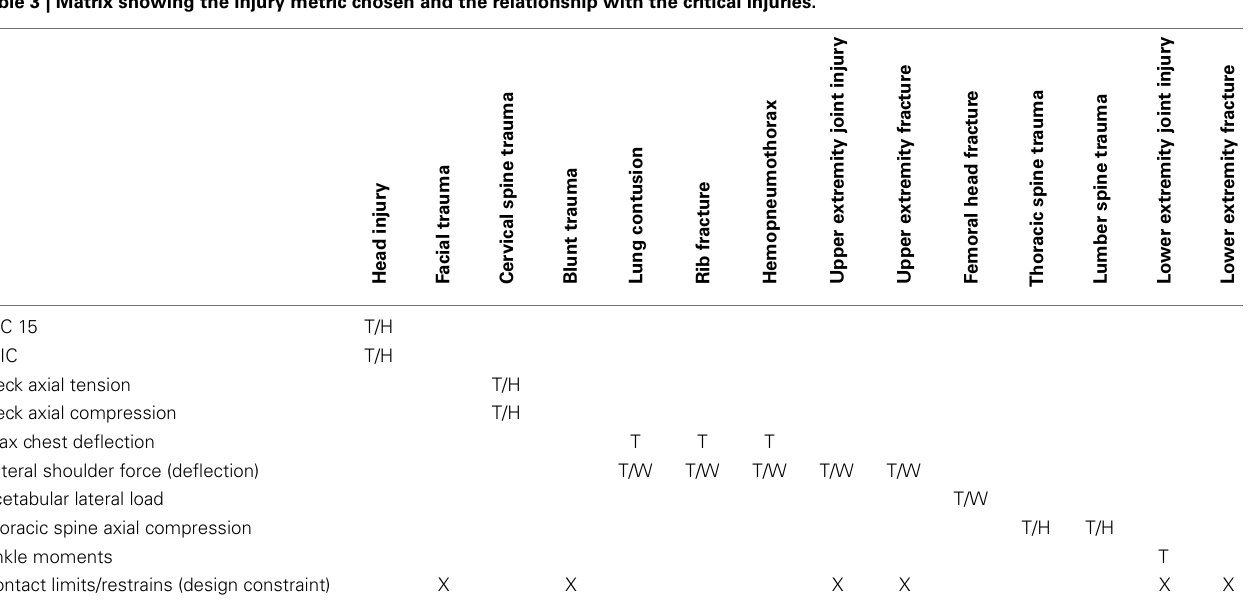
Table 3 | Matrix showing the injury metric chosen and the relationship with the critical